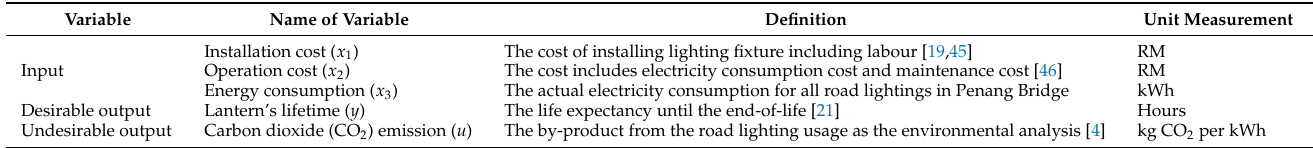
Table 2. List of variables.